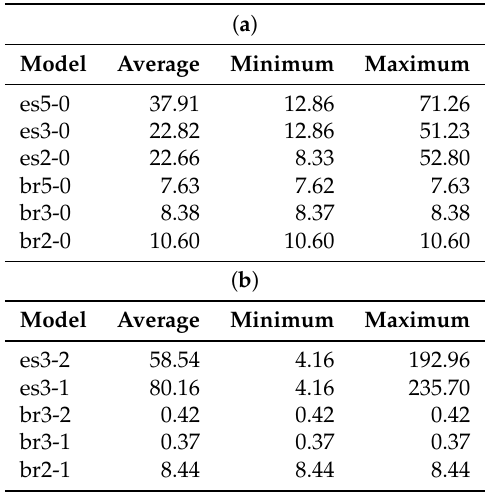
Figure 12. Identification results and regulation comparison multilayer feedforward neural networks for the steering-grid thruster: ( a ) one hidden layer, ( b ) two hidden layers. Table 3. Residuals cost functions of the multilayer feedforward neural networks for Figure 12: ( a ) one hidden layer, ( b ) two hidden